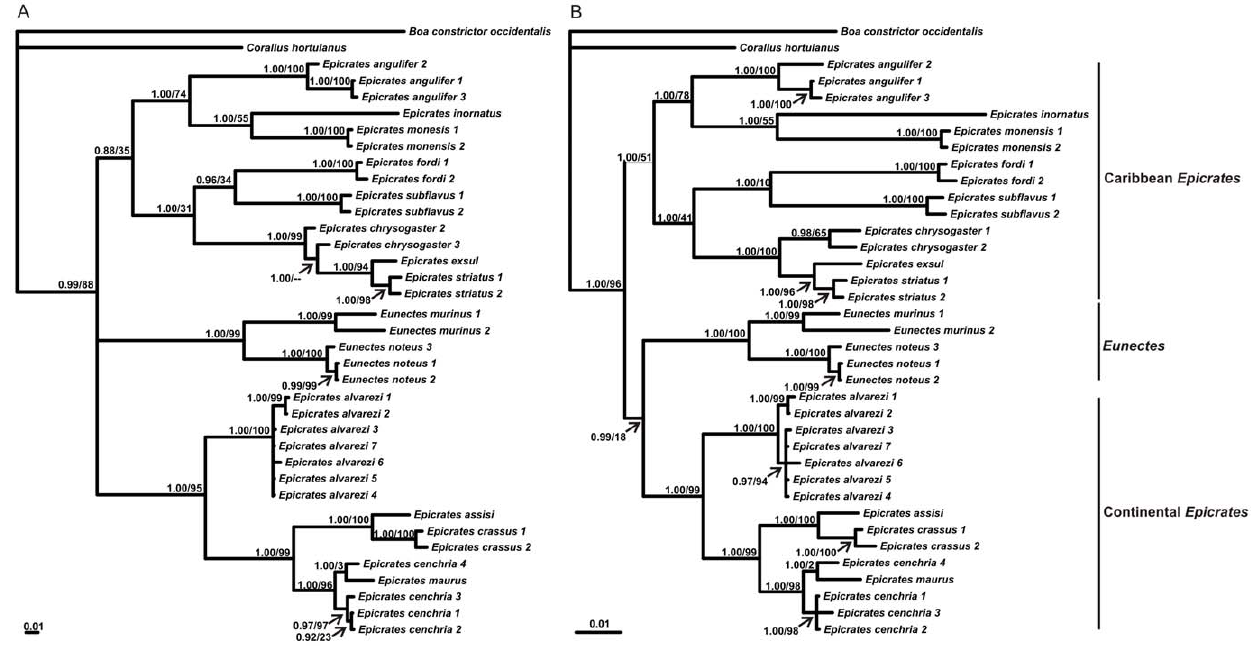
Figure 8. Bayesian phylogram of the 50% of majority rules consensus tree obtained from (A) the mtDNA data set (cytochrome b gene) and (B) the mtDNA (cytochrome b gene) and nDNA data set (RAG-1, NT-3 and c- mos genes). The topology is highly congruent to that of maximum parsimony. The node supports are as following: Bayesian posterior probabilities/bootstrap support after 1000 replicates in MP